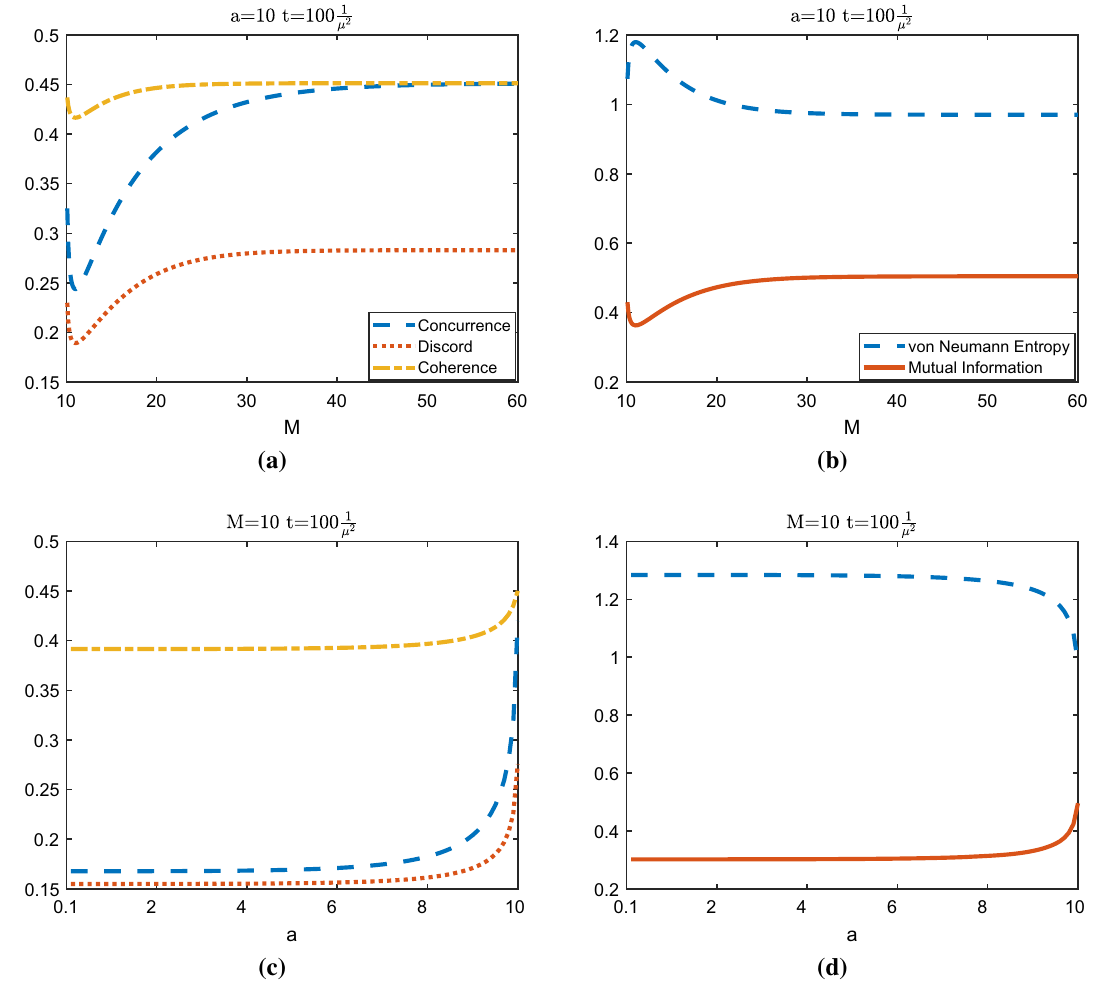
Fig. 6 a , b Quantum correlations at nonequilibrium transient state vs. mass when t = 100 μ transient state vs. the angular momentum per mass when t = 100 μ